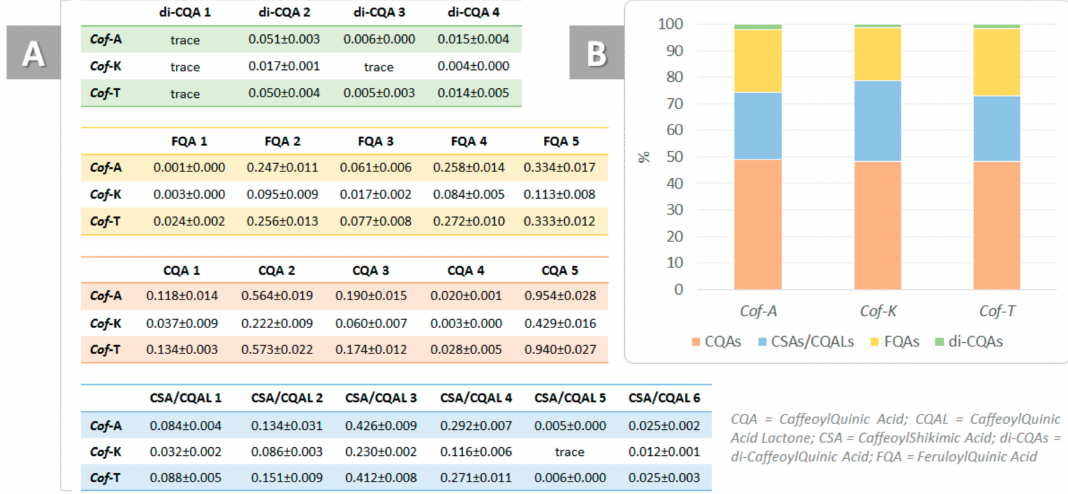
Figure 8. ( A ) Chlorogenic acids amounts, expressed as wt % of dried moka co ff ee drinks ( Cof -A = co ff ee enriched with C. sativa cv . Antal shredded inflorescences; Cof -K = co ff ee enriched with C. sativa cv . Kompolti shredded inflorescences; Cof -T = co ff ee enriched with C. sativa cv . Tiborszallasi shredded inflorescences); ( B ) % of the four subclasses in each